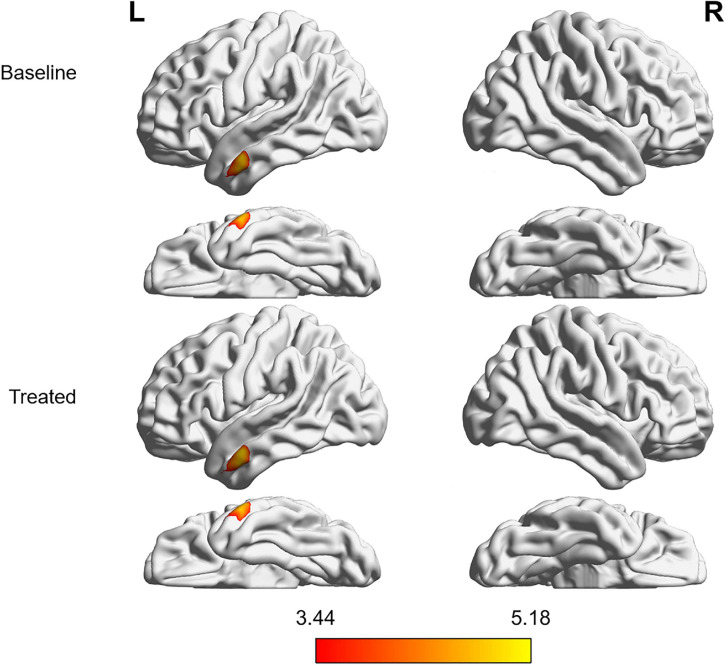
Intergroup differences in GMV between tinnitus patients without HL and HCs before and after sound therapy. At baseline, compared with the HCs, the patients with tinnitus without HL exhibited reduced GMV in the left MTG. After sound therapy (treated), the tinnitus patients continued to show decreased GMV in the same region, and the volume of gray matter was further reduced (corrected at the non-stationary cluster level with FWE P < 0.05). HL, hearing loss, HC, healthy control, MTG, middle temporal gyrus, FWE, family wise error, GMV, gray matter volume. The color bar represents the extent of reduction in GMV.